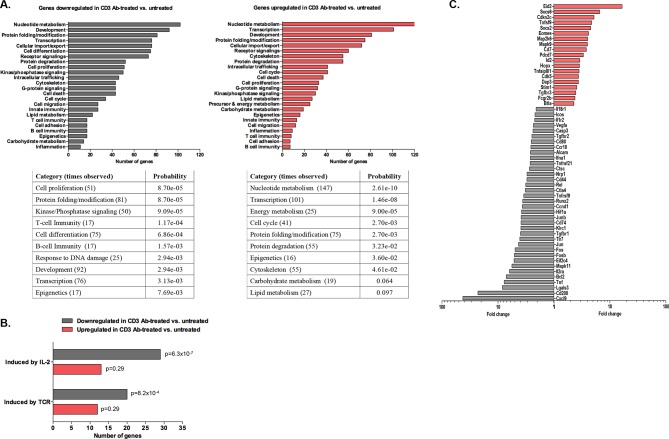
Transcriptomic analysis of tolerant intragraft CD8+ T cells after CD3 Ab therapy.Five hundred graft-infiltrating CD8+ T lymphocytes were sorted from untreated or CD3 Ab-treated C57BL/6 mice, on day +14 and day +100, respectively (n = 8 per group). Agilent Whole Mouse Genome Microarrays were performed after amplification of RNAs. Functional grouping analysis used annotations derived from Gene Ontology (fold-change >2, p<0.05). (A) Bar chart showing the frequency of representative categories downregulated (left panel) or upregulated (right panel) in tolerant CD8+ T cells as compared to CD8+ T cells from untreated recipient mice. Below, statistically enriched categories were indicated by their adjusted p-value (only the top 10 categories, Fisher’s exact test with Benjamini-Hochberg correction for multiple testing). (B) Bar chart showing the frequency of target pathways induced by IL-2 ou TCR signaling. (C) Selection of immune genes that were downregulated (grey bars) or upregulated (red bars) in tolerant CD8+ T cells as compared to CD8+ T cells from untreated recipient mice (fold-change >2, p<0.05).DOI:
http://dx.doi.org/10.7554/eLife.08133.01710.7554/eLife.08133.018Figure 8—source data 1.Genes upregulated in anergic CD8+ T cells from CD3 Ab-treated recipient mice.